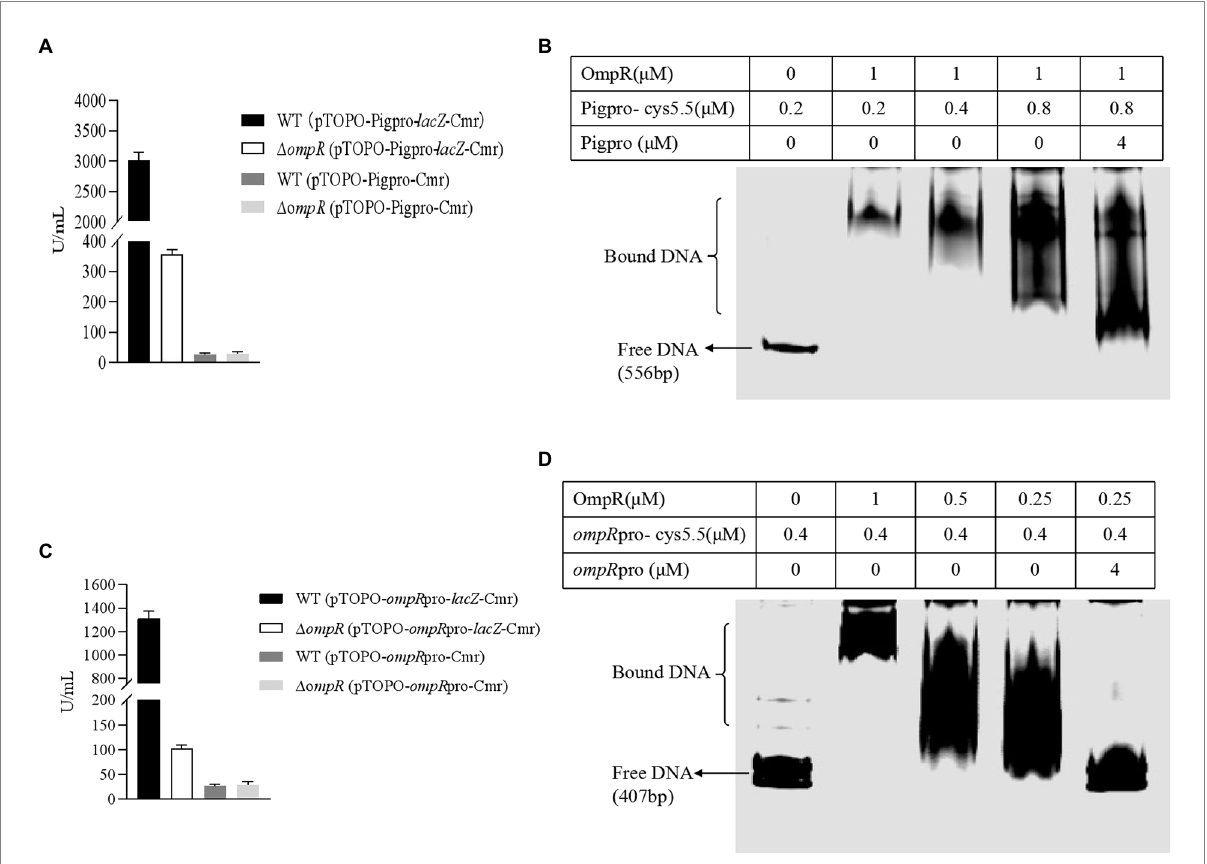
FIGURE 2 OmpR regulates the prodigiosin-producing ability of FZSF02 directly. (A) Analysis of β -galactosidase activity of ∆ ompR (pTOPO- Pig pro- lacZ -Cmr) and WT (pTOPO- Pig pro- lacZ -Cmr) harboring the Pig pro- lacZ reporter fusion. WT (pTOPO- Pig pro-Cmr) and ∆ ompR (pTOPO- Pig pro-Cmr) were constructed as controls. (B) EMSA for OmpR protein binding to the promoter of the pig cluster. (C) Analysis of β -galactosidase activity of ∆ ompR (pTOPO- ompR pro- lacZ -Cmr) and WT (pTOPO- ompR pro- lacZ -Cmr) harboring the ompR pro- lacZ reporter fusion. WT (pTOPO- ompR pro-Cmr) and ∆ ompR (pTOPO- ompR pro-Cmr) were constructed as controls. (D) EMSA for assay OmpR protein binding ability to the promoter of envZ / ompR